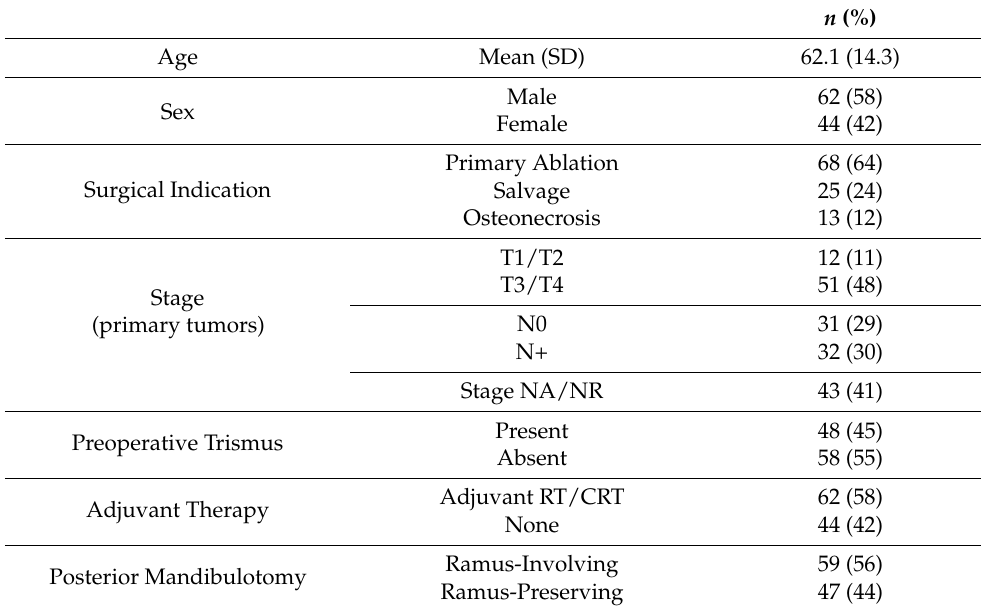
Table 1. Baseline demographic characteristics and treatment variables for the study cohort.